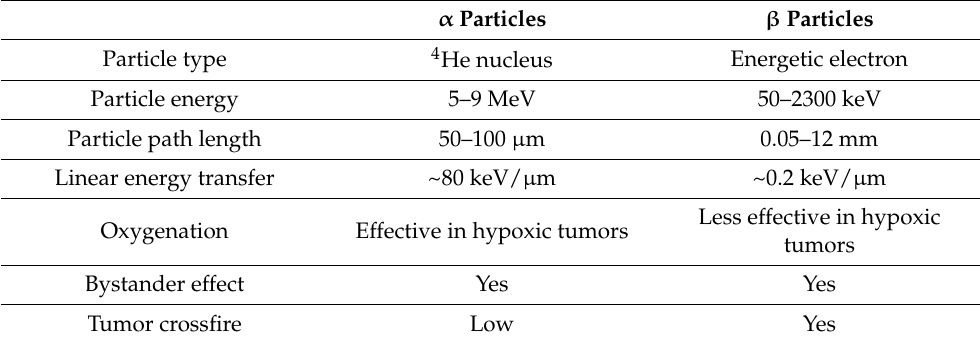
Table 4. Physical and biological differences between α and β particles. α Particles β